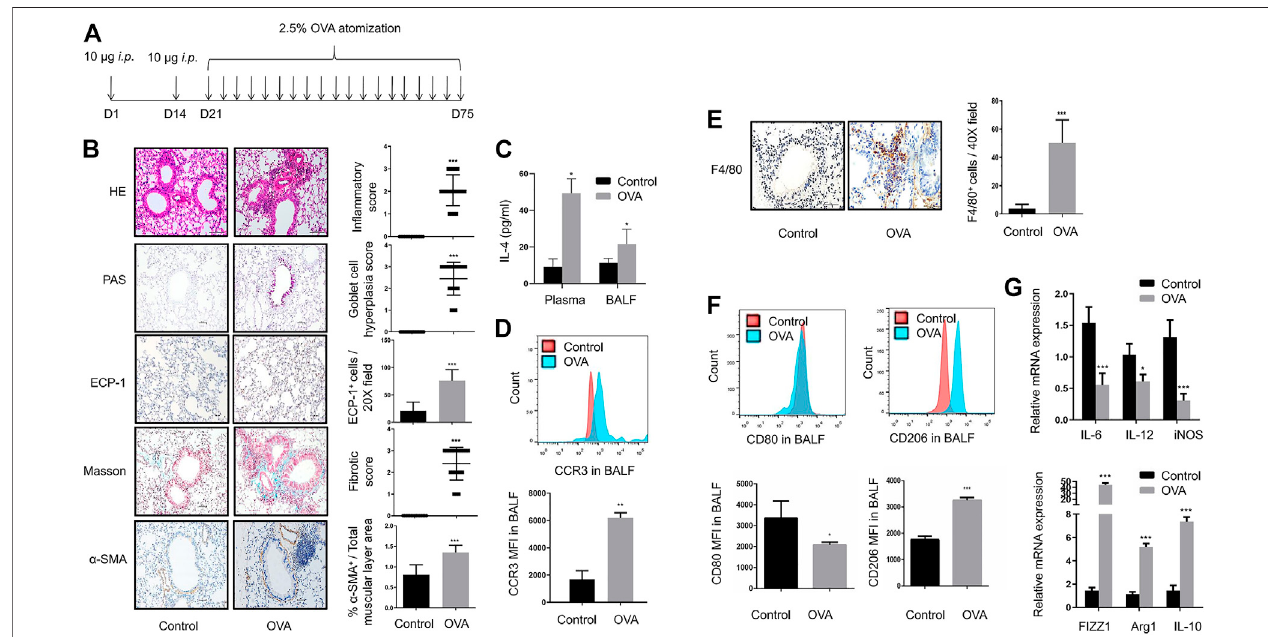
FIGURE 1 | Airway in fl ammation and remodeling along with M2 macrophage polarization in OVA-sensitized mice with chronic asthma (A) . Timeline of establishment of the chronic asthma model which was sensitized and challenged with OVA for 8 weeks (B) . Representative images of HE, PAS, Masson, ECP-1, and α -SMAimmunohistochemistrystainingoflungsectionsfromcontrolandOVA-sensitizedmiceasshownatamagni fi cationof20X.Scalebar:50 μ m.Bargraphrepresent morphometricsemi-quantitativeanalysisofhistopathologicaldatafromHE,PAS,andMassonstaining.Quanti fi cationofECP-1 + cellsper20X fi eldandpercentage of α -SMA + /totalmuscularlayerarea (C) .IL-4levelsinplasmaandBALFfromcontrolandOVA-sensitizedmiceassessedbyELISA (D) .ExpressionofCCR3inBALFfrom control and OVA-sensitized mice as determined by fl ow cytometry analysis. The representative histograms and quantitation of the MFI are shown (E) . Representative images of F4/80 immunohistochemistry staining of lung sections from control and OVA-sensitized mice as shown at a magni fi cation of 40X. Scale bar: 50 μ m. Quanti fi cation of F4/80 + cells per 40X fi eld (F) . Expression of CD80 and CD206 in alveolar macro-phages of BALF from control and OVA-sensitized mice as determined by fl ow cytometry analysis. The representative histograms and quantitation of the MFI are shown (G) . Expression of IL-6, IL-12, iNOS, FIZZ1, Arg1, and IL-10 in lungs from control and OVA-sensitized mice evaluated by RT-qPCR. ( n (cid:2) 8, * p < 0.05, ** p < 0.01, *** p < 0.001 vs. control